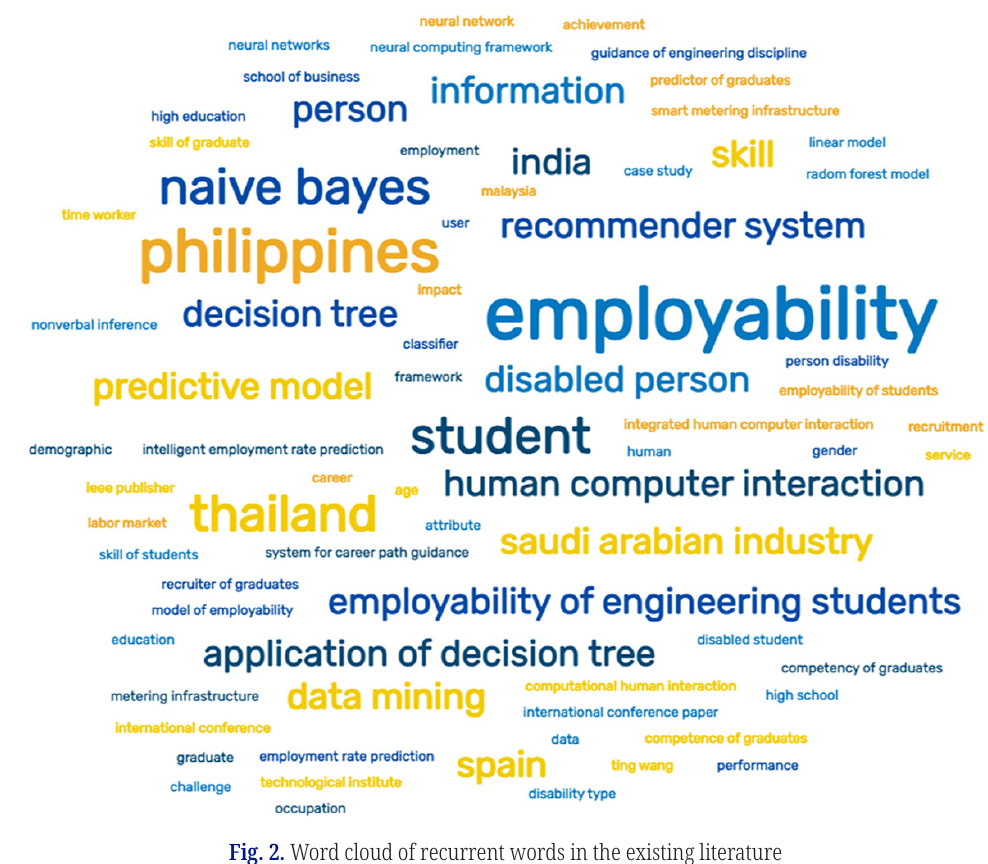
Fig. 2. Word cloud of recurrent words in the existing